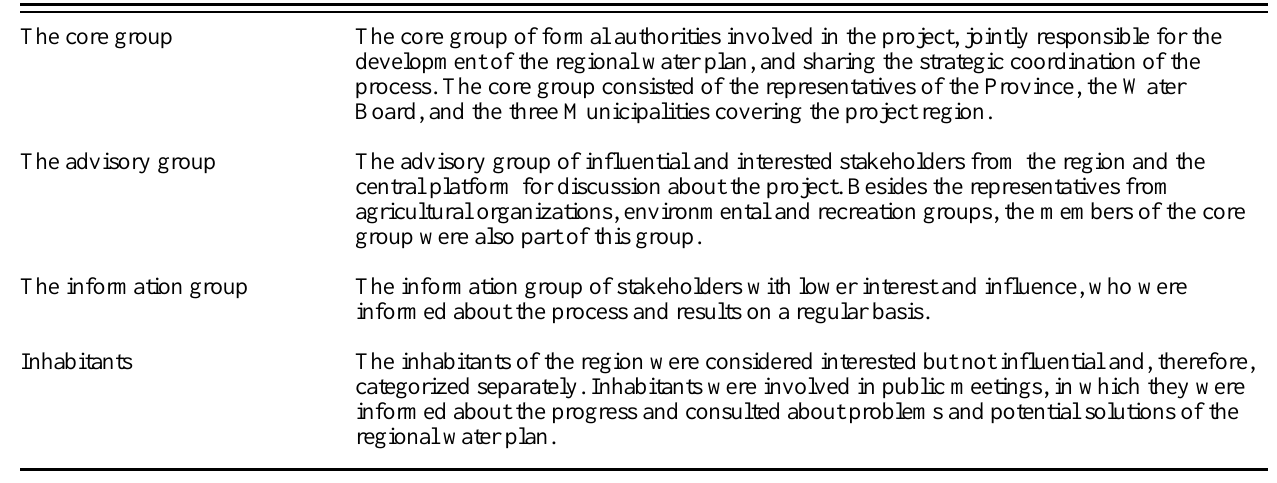
Table 2. Different groups in the Kromme Rijn participation process. The core